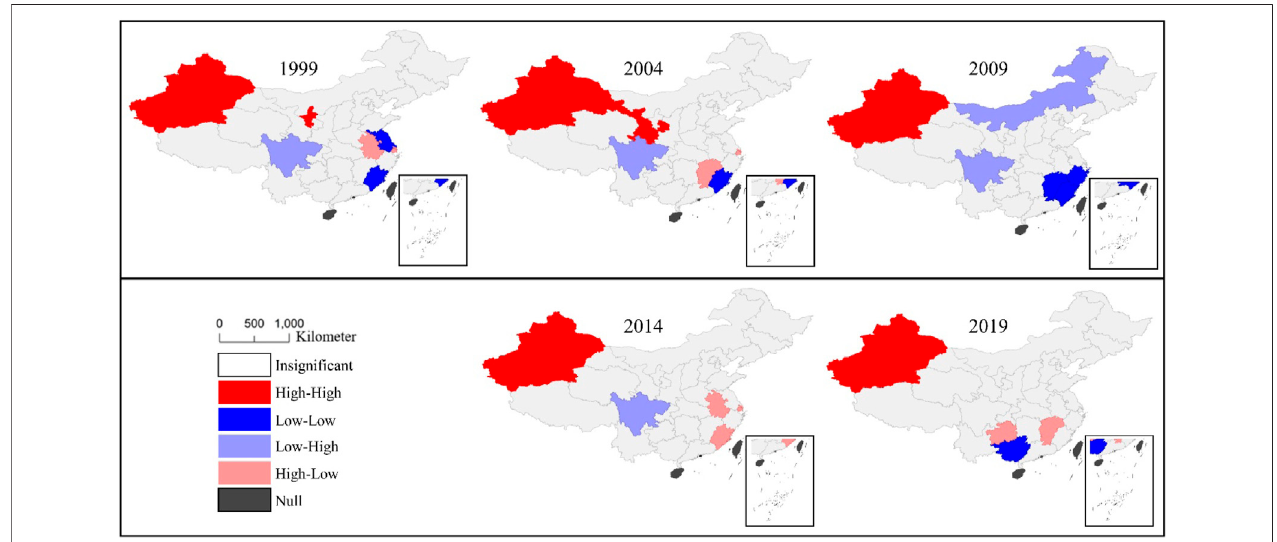
FIGURE 10 | Types of local autocorrelation aggregates for fi re situations in